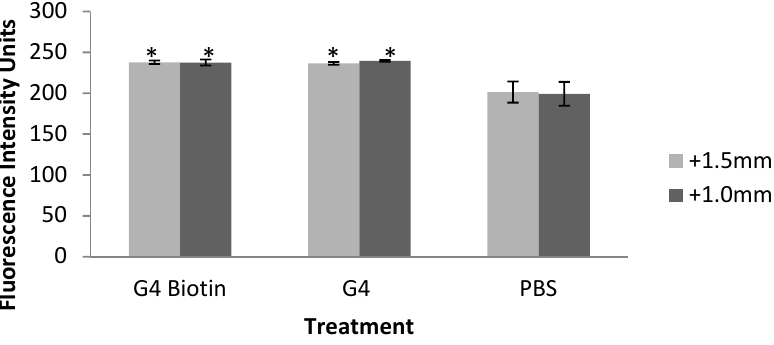
Figure 2. Fluorescence intensity measurements of rat brain dorsal striatum at 2 levels of bregma (+1.5mm and +1.0mm) in rats exposed to G4 PAMAM dendrimers, biotinylated G4 PAMAM dendrimers, and PBS (control). Values represent mean ± SEM. * p < 0.05 compared to PBS controls using Tukey post-hoc